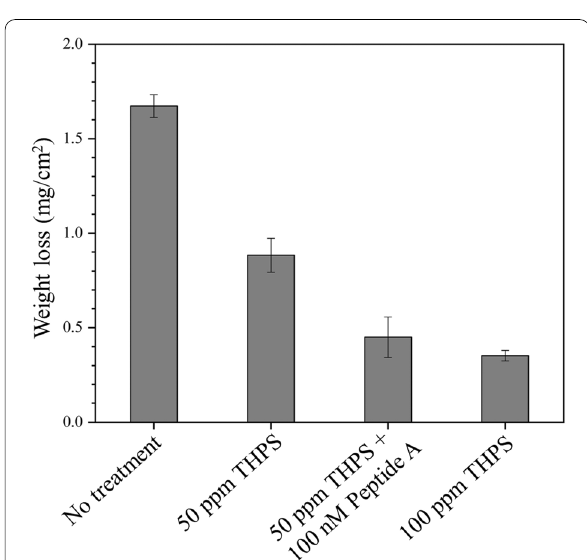
Fig. 8 Weight losses of C1018 carbon steel coupons with different biocide treatments after 7-day incubation in flow loop bioreactors (error bars represent standard deviation from three independent